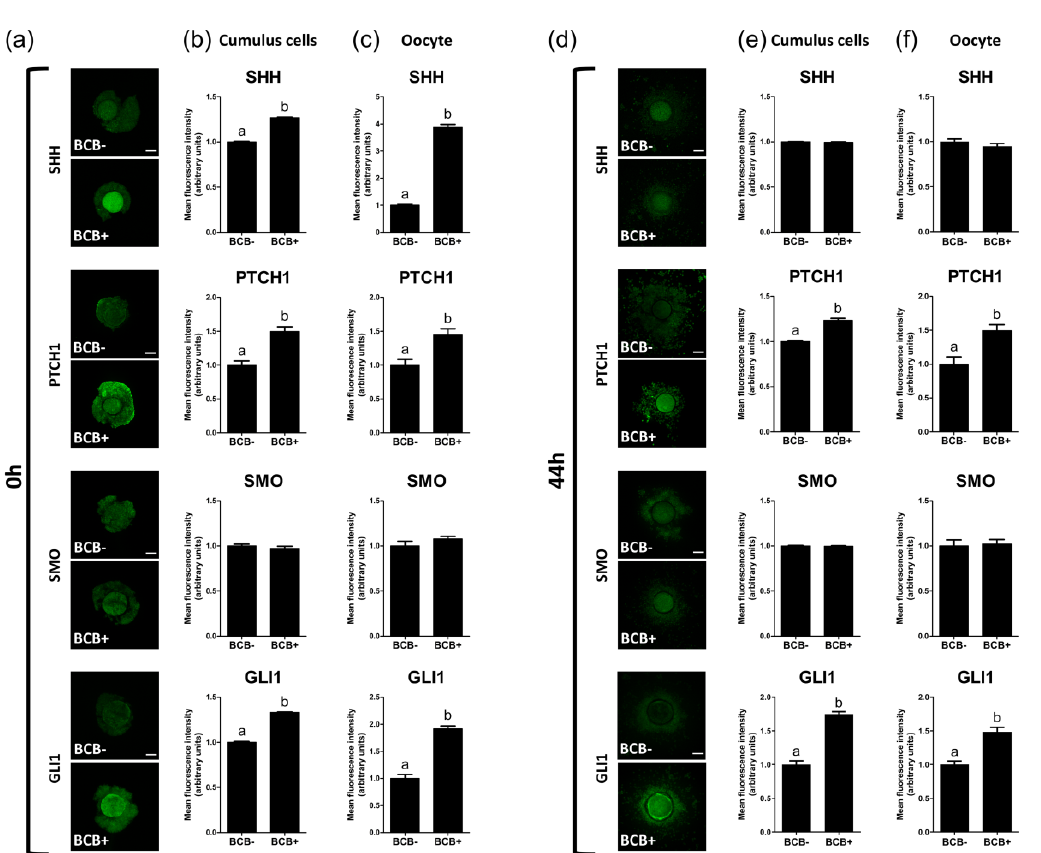
Figure 4. Immunocytochemical analysis of Sonic hedgehog (SHH)-signaling proteins in BCB- and BCB+ porcine cumulus-oocyte complexes (COCs). Representative images of porcine COCs of each group stained with antibodies directed against SHH, PTCH1, SMO, and GLI1 and comparison of expression in cumulus cells and oocytes after 0 h ( a – c ) and 44 h ( d – f ) of in vitro maturation, respectively. Within each category, groups marked with different letters are significantly different ( p < 0.05). Bar = 100 μM.